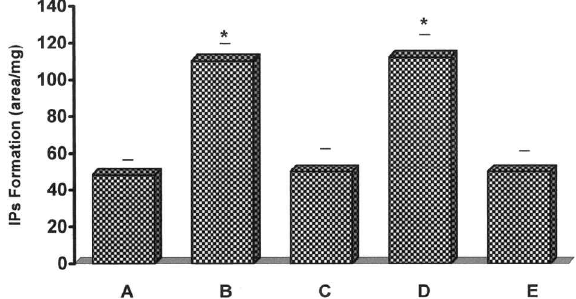
FIG. 1. ThEA action on the accumulation of IPs of rat submandibular gland slices. The effect of the H 1 receptor agonist (1 ´ 10 –7 M) ThEA alone (B), or in the presence of the H 1 receptor antagonist (1 ´ 10 –6 M) pyrilamine (C), or the H 2 receptor antagonist (1 ´ 10 –6 M) cimetidine (D), and the PLC inhibitor (5 ´ 10 –6 M) U-73122 (E) above basal values (A) was analysed. Results presented as the mean ± SEM of seven experiments performed in duplicate in each case. * Differ significantly from (A) with p < 0.001.